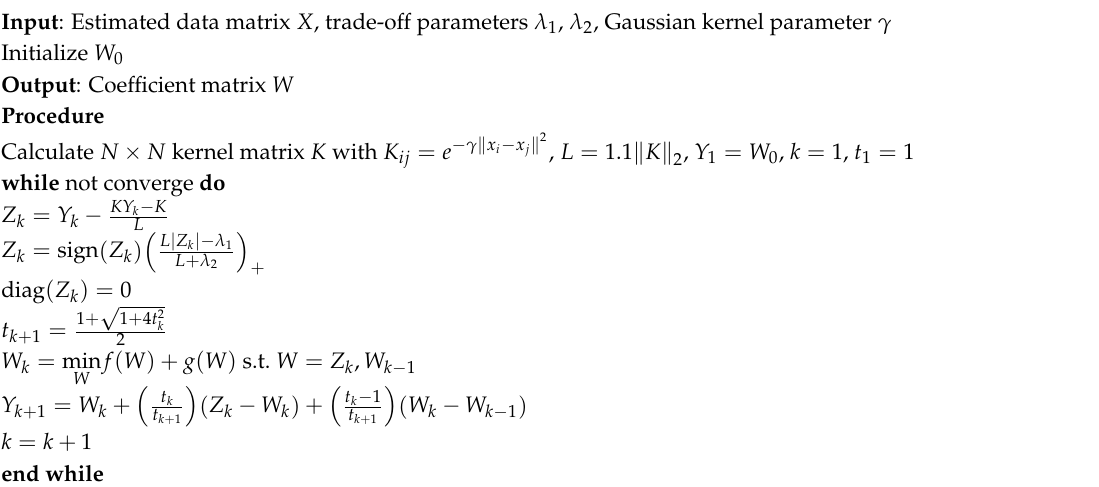
Algorithm 1. Monotone fast iterative shrinkage thresholding algorithm for solving